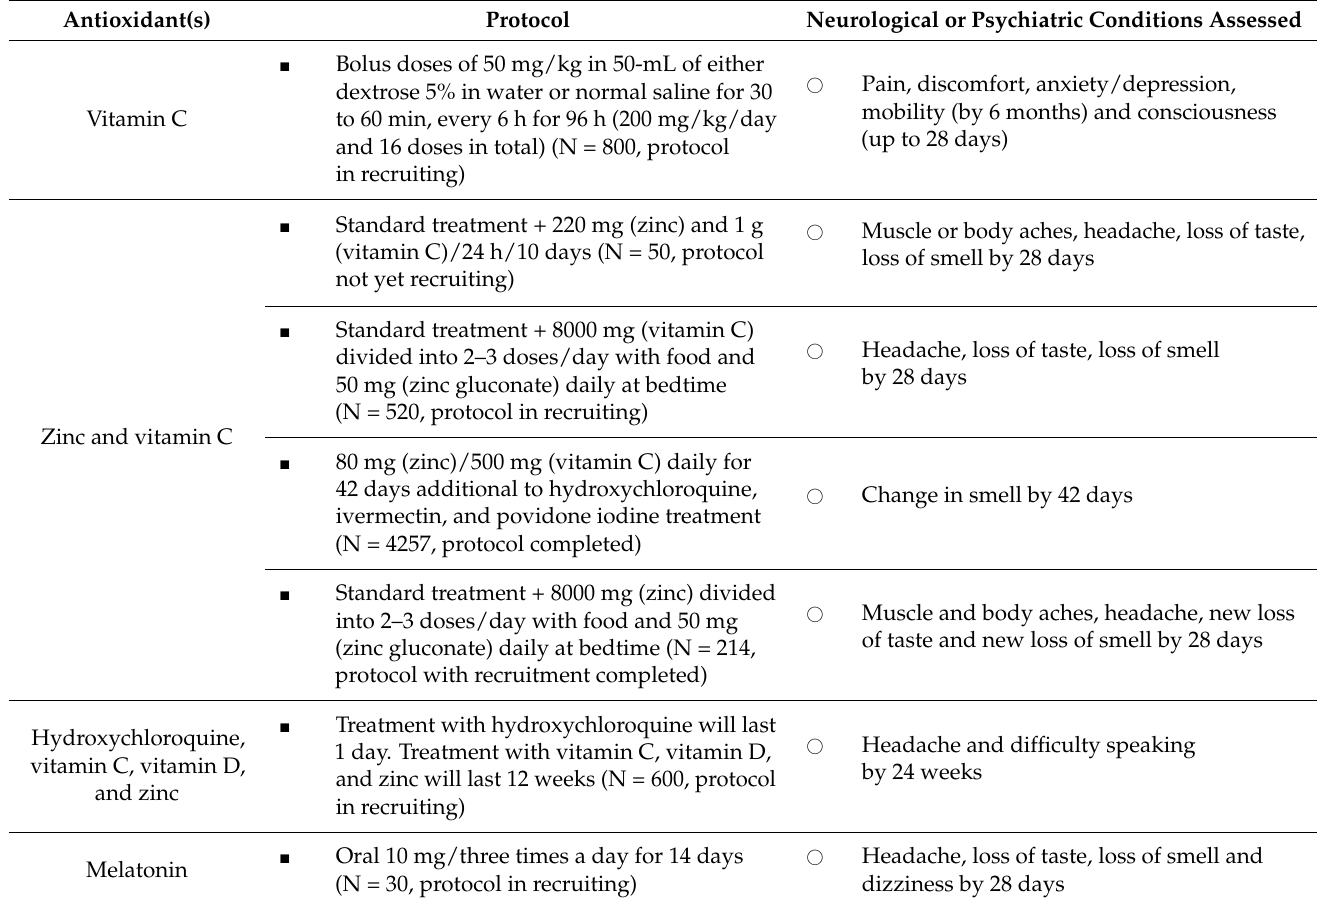
Table 3. Current clinical trials evaluating the effect of antioxidant compounds on neurological manifestations in COVID-19.